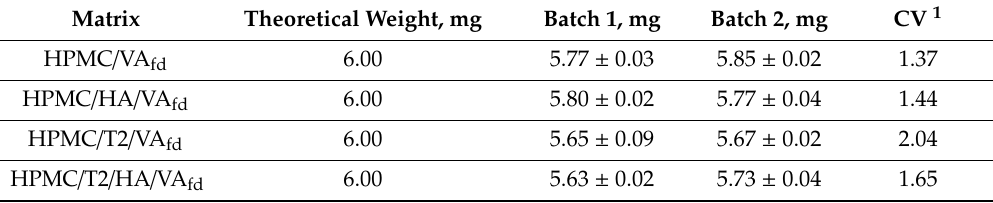
Table 3. Freeze-dried matrices weight of two di ff erent batches, Mean ± SE, n = 6.